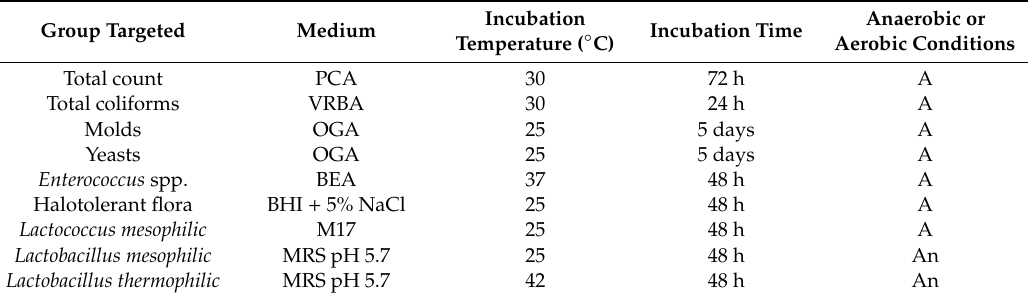
Table 2. Medium and incubation